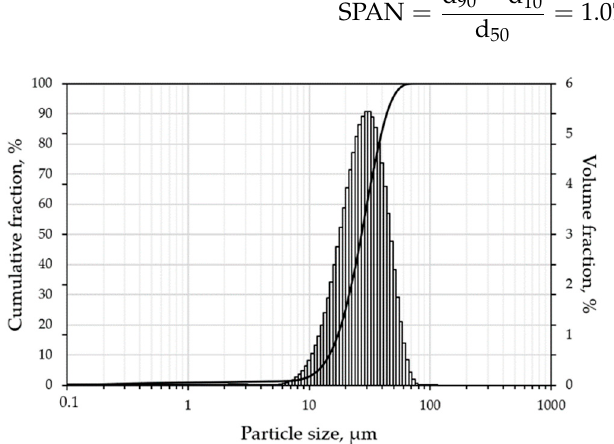
Figure 3. Particle size distribution histogram with cumulative curve.